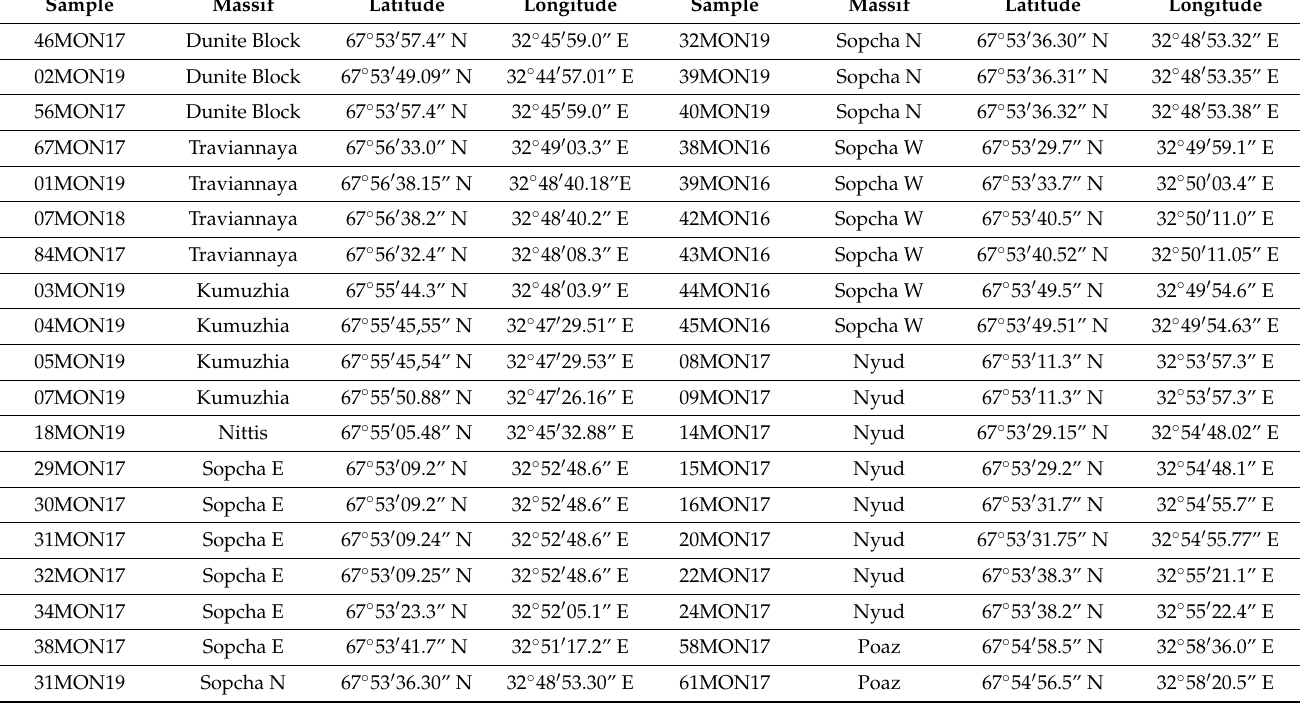
Table 1. Location of samples from the Monchepluton massif used for fractal